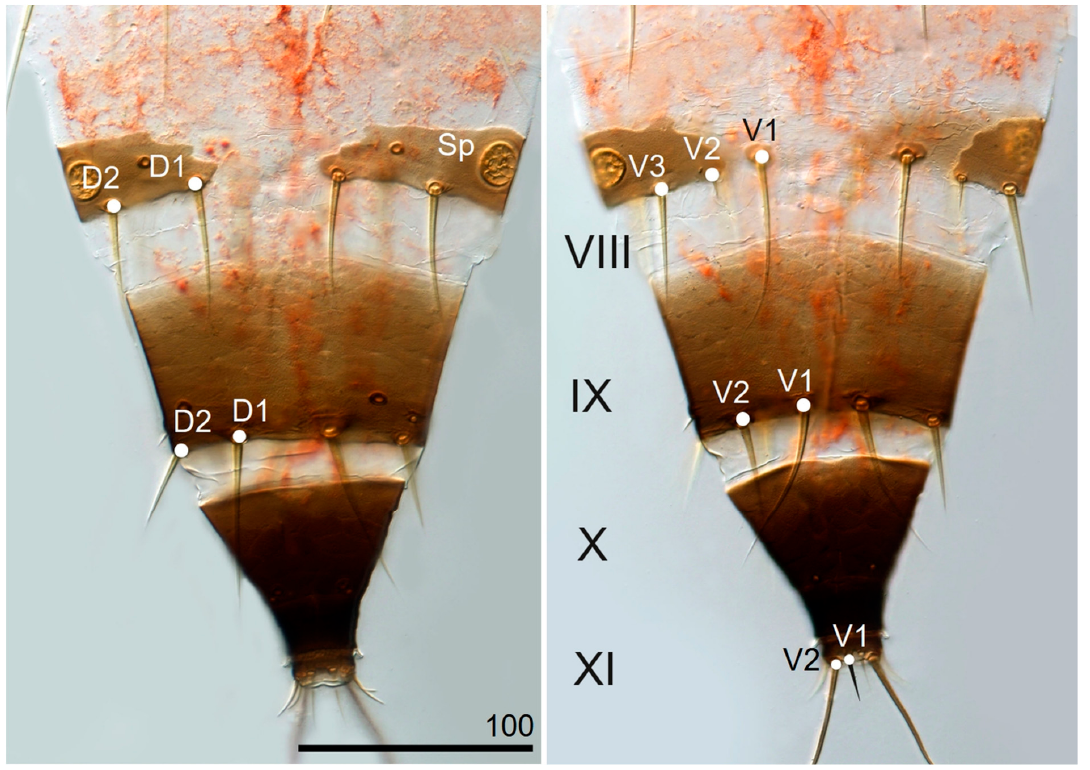
Figure A1. H. leucanthemi —second larval instar: body view ( right ), head and pronotum ( left , above ), meso- and metanotum ( left , below ), Sp—spiracle, D1–D7—dorsal setae on head and thorax included in morphometric measurements (Table 2).